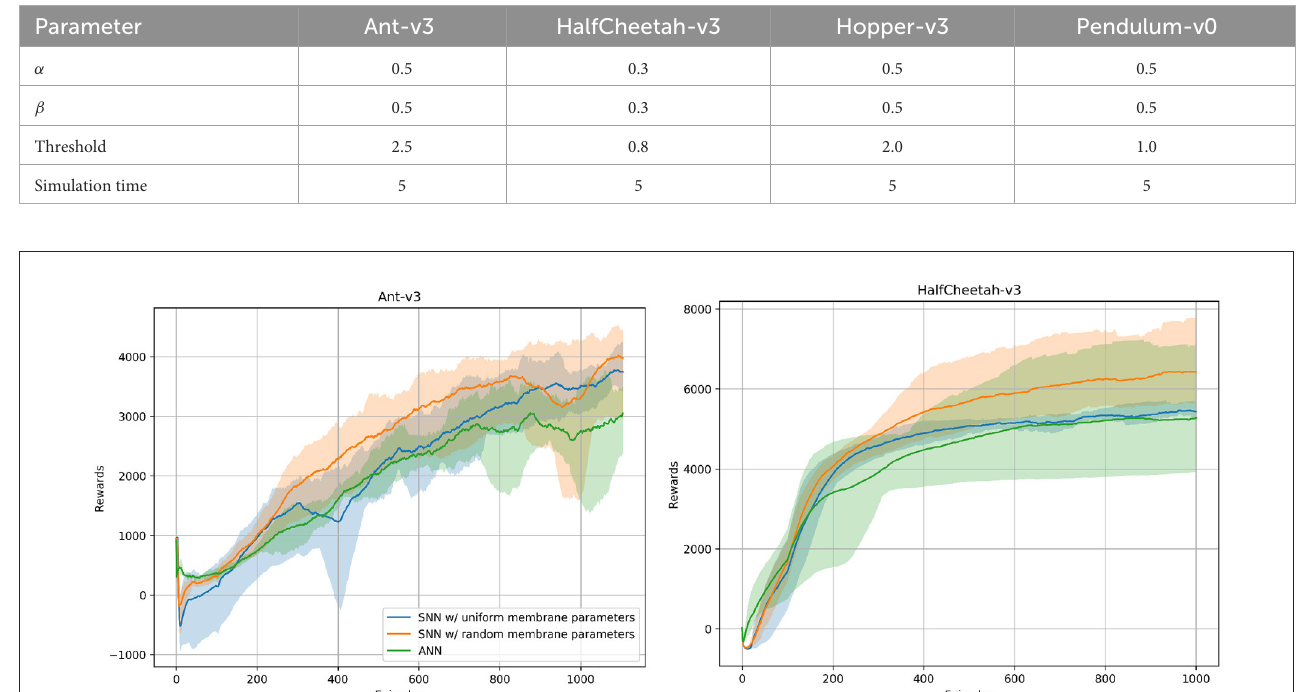
TABLE 2 SNN parameters (current decay, voltage decay, firing threshold, and simulation time) used during training for all environments.